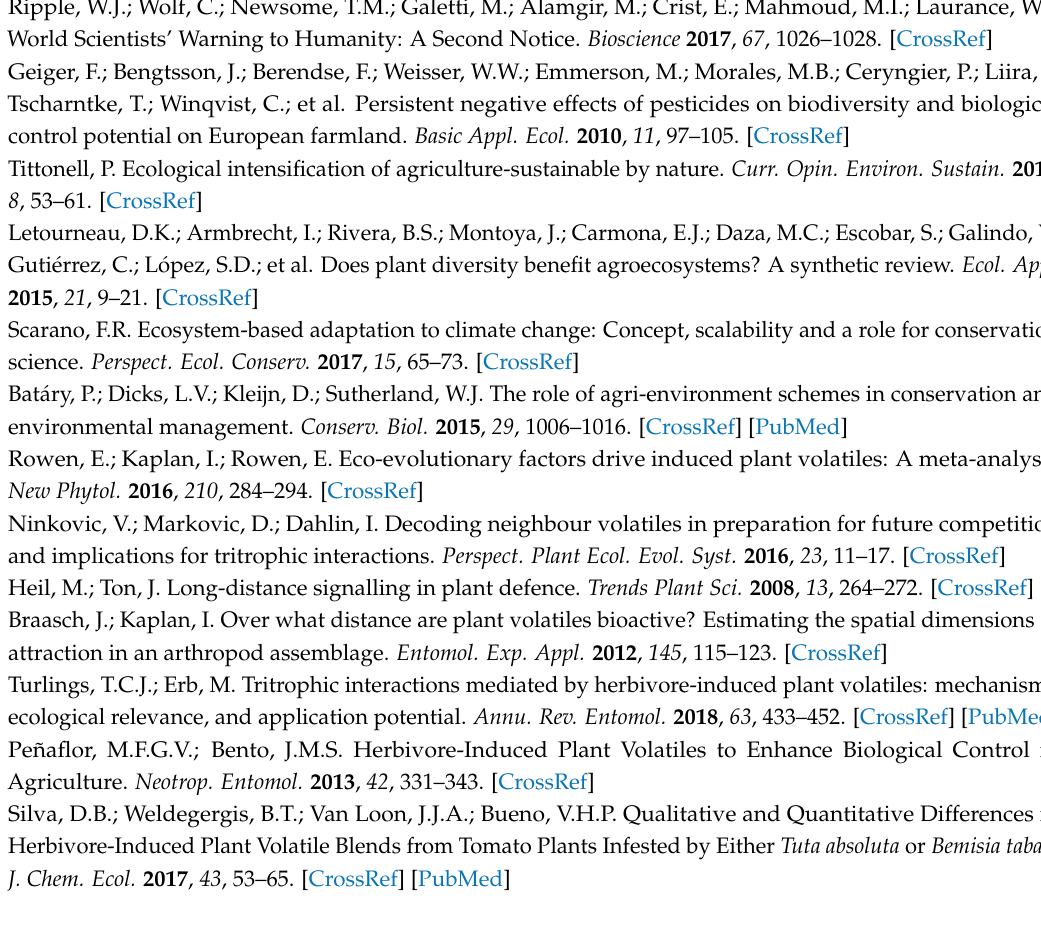
Figure S1: Schematic representation of the trapping experiment with McPhail traps in apple orchards and how they were rotated, Table S1: Coefficient estimation for volatile